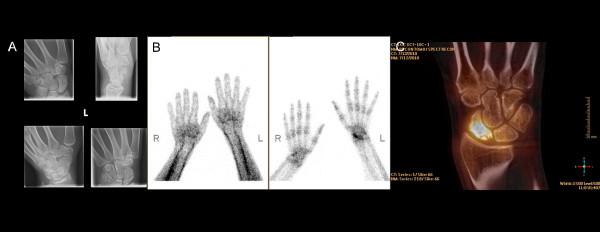
A 28-year-old male with suspected RC osteoarthritis after scaphoid fracture 6 years ago. The patient has a consolidated pseudoarthrosis of the scaphoid bone and persistent wrist pain. (A) Plain radiographs show focal sclerosis of the proximal pole of the scaphoid. (B) Planar bone scan revealed uptake in the scaphoid bone on late-phase images (left: early phase, right: late phase). (C) Coronal SPECT/CT images showed uptake in the proximal scaphoid (osseous remodeling) and a vital proximal scaphoid fragment. The patient received revisional osteosynthesis of the scaphoid.